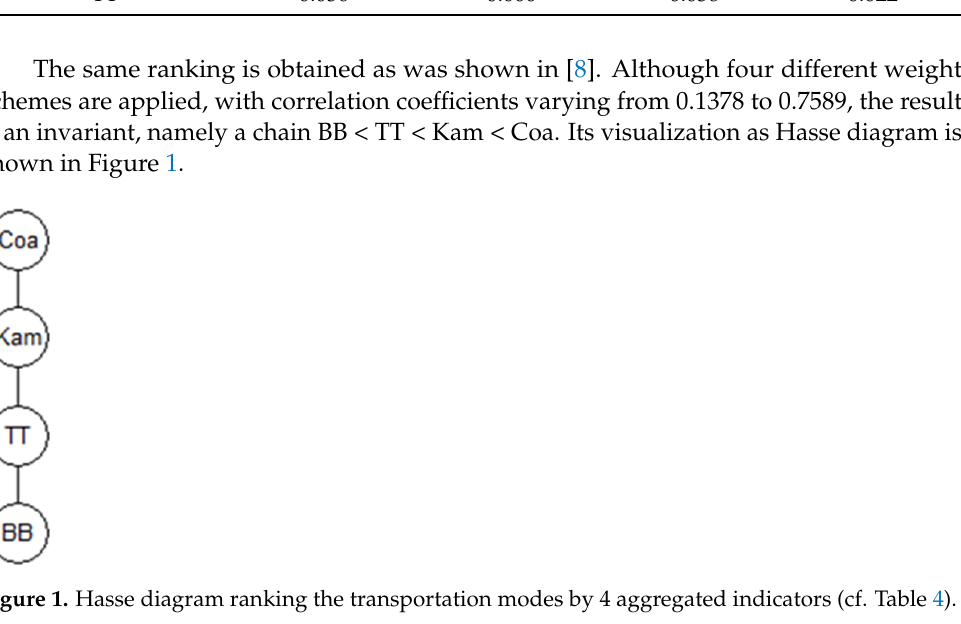
Figure 1. Hasse diagram ranking the transportation modes by 4 aggregated indicators (cf. Table 4).